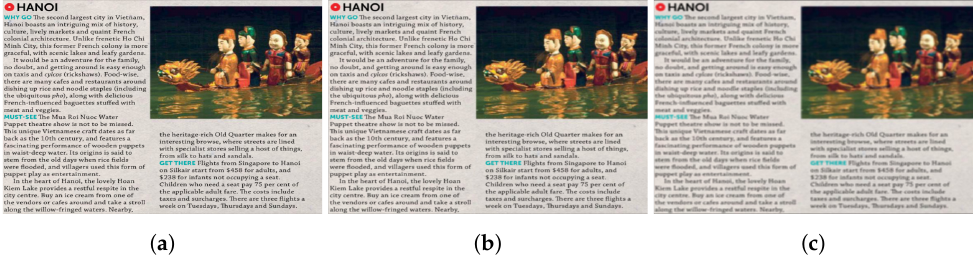
Figure 9. The quantity of visual information contained in images with different distortion levels, the distortion levels from ( a – c ) increase gradually. ( a ) υ I = 5.19, q’ = 17447.85, ( b ) υ I = 4.62, q’ = 13406.79, ( c ) υ I = 4.32, q’ =